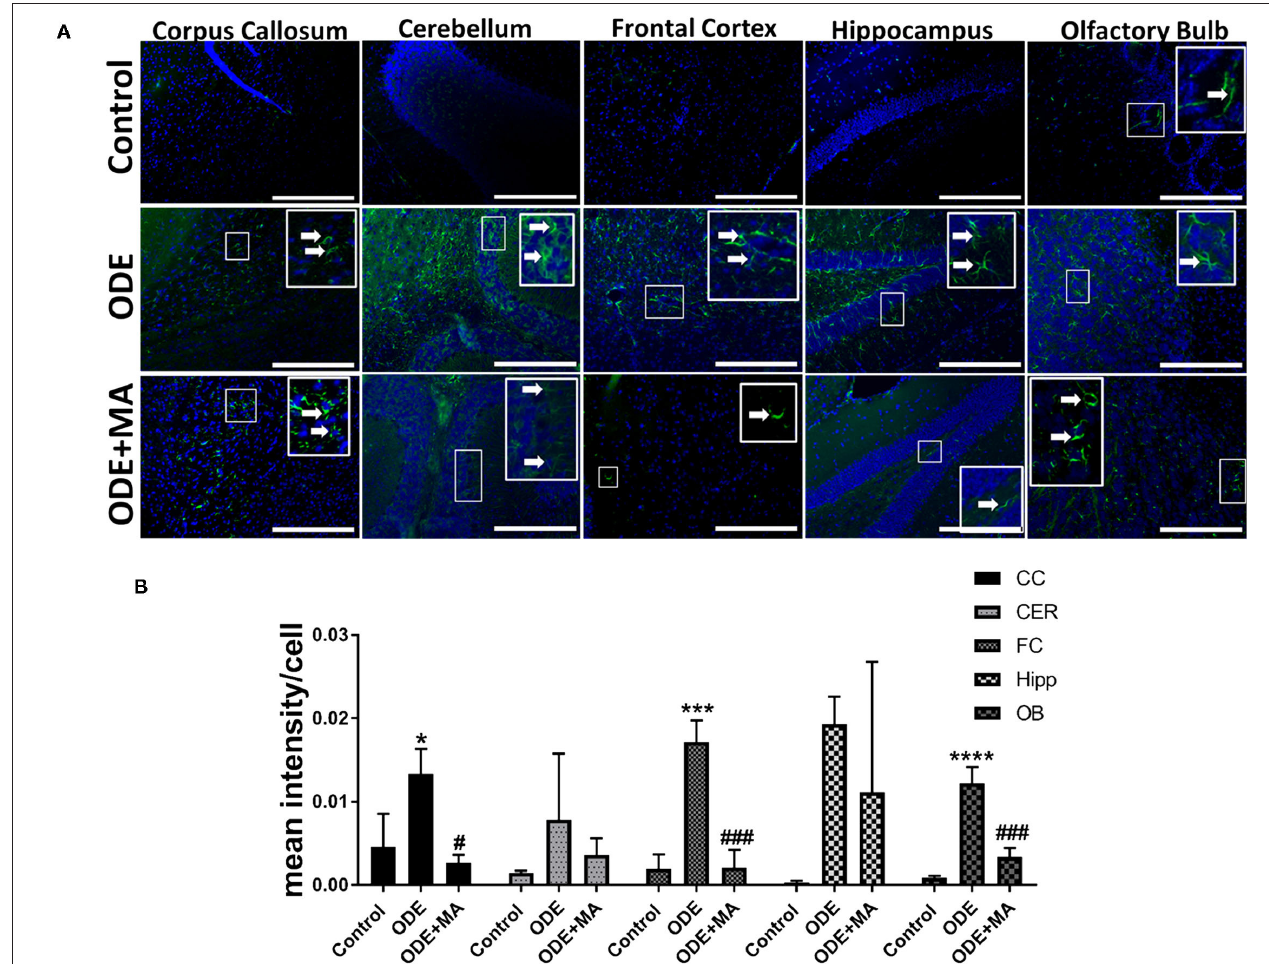
FIGURE 5 | ODE induces glial fibrillary acidic protein (GFAP) expression in various regions of mice brain. Paraffin-embedded sections from perfused mice brain were stained with anti-GFAP (white arrow, FITC, green) antibody and nuclei were identified with DAPI (blue) (A) . GFAP expression in IHC was quantified by a blinded investigator. Compared to control, ODE-exposed mice showed higher amounts of GFAP staining in the corpus callosum, frontal cortex, and olfactory bulb of the brain. MA (C11) treatment significantly reduced GFAP expression in the corpus callosum, frontal cortex, and olfactory bulb regions of brain (B) ( n = 5, *exposure effect, # MA treatment effect, p < 0.05, micrometer bar = 50 µ